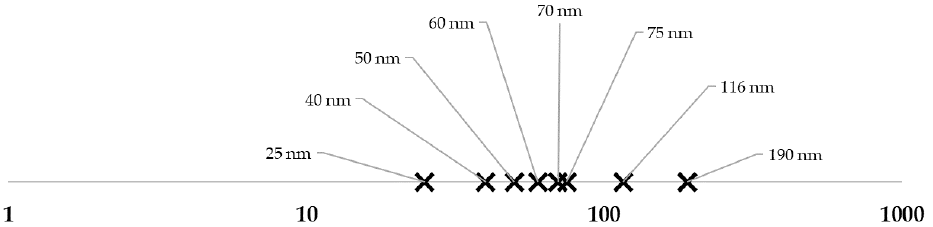
Figure 2. NPs’ sizes (nm) from the studies included for review: 25 and 70 nm [31]; 40 nm [17]; 50 nm [32]; 60 to 75 nm [35]; 116 nm [20]; 190 nm [33,34] Upper limit of 1000 nm defined based on reviewed literature [8].